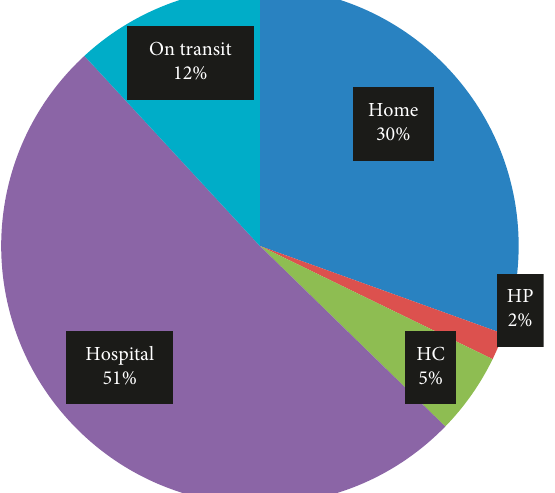
Figure 1: Maternal death by place among pastoralist pregnant women in the Borena zone of Oromia region, Ethiopia, 2017.